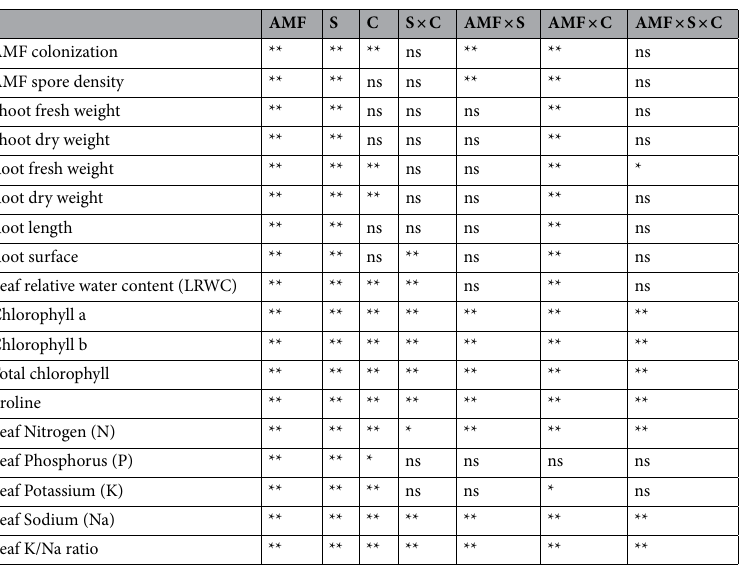
Table 1. ANOVA table showing the effects of arbuscular mycorrhizal fungi (AMF), salinity (S) and Eucalyptus clone (C) and their interactions on mycorrhizal fungal and plant traits. Ns non-significant, *Significant at P ≤ 0.05 and **Significant at P ≤